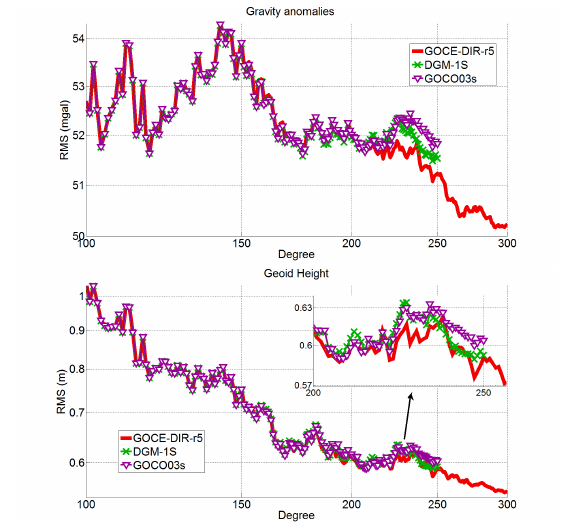
Figure 7: RMS variations in gravity anomaly and geoid height that have been obtained from comparison between terrestrial data and computed values based on gravity models derived from optimum combination of GRACE and GOCE data. RMS differences are cap- tured over the degree 200.